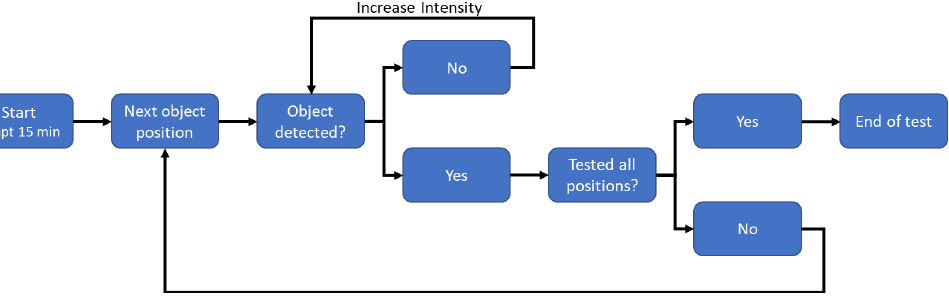
Figure 6. Flowchart of the experimental procedure for a